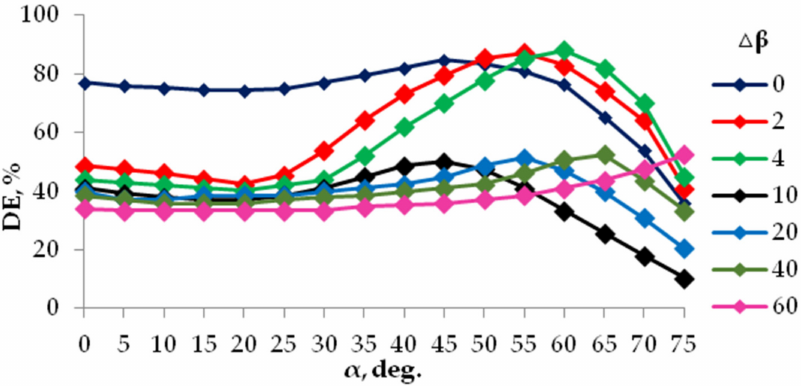
Figure 5. Dependence of diffraction efficiency of hybrid structures on angles α and β , obtained using Scheme